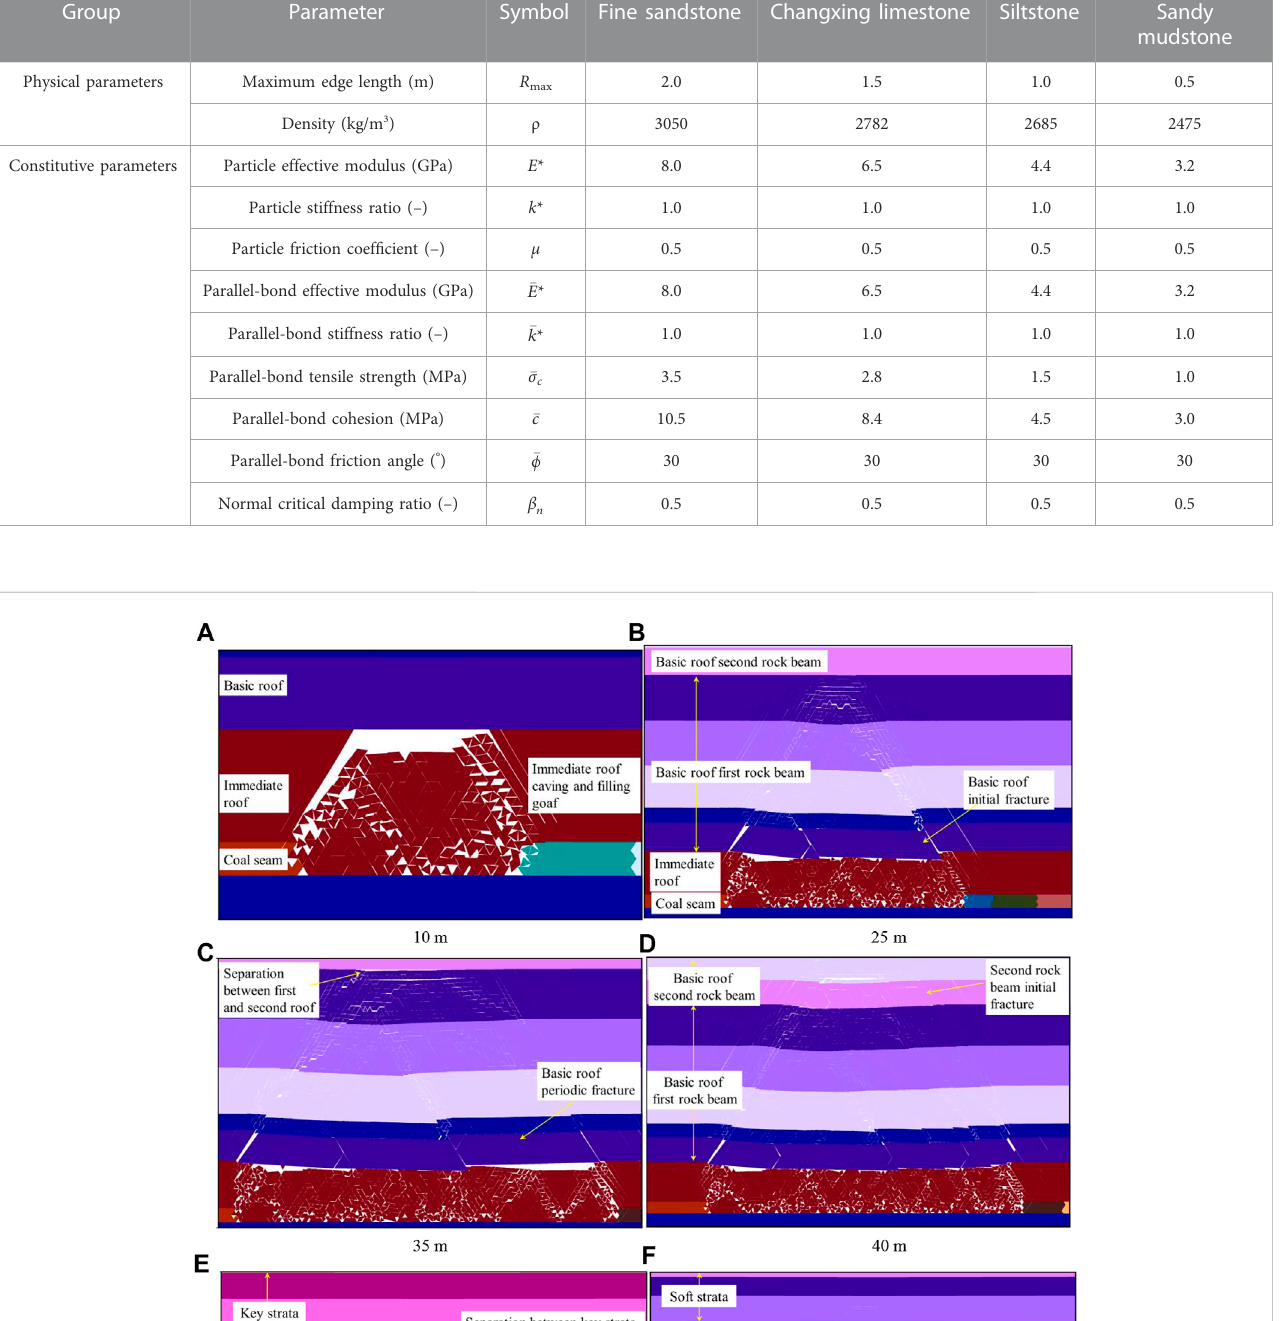
FIGURE 11 Roof fracture and movement characteristics. (A) 10 m. (B) 25 m. (C) 35 m. (D) 40 m. (E) 80 m. (F) 150 m.